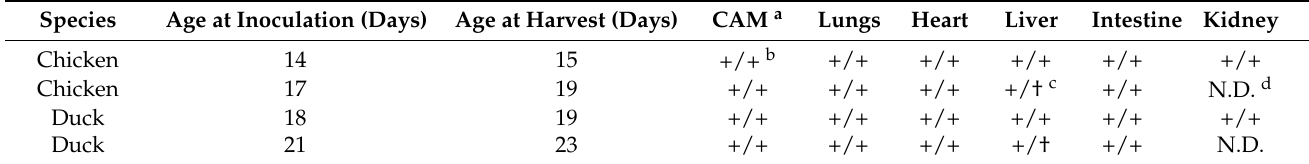
Table 2. CAM and embryonic tissues of ECE and EDE containing NP-positive endothelial cells upon inoculation with HPAIV